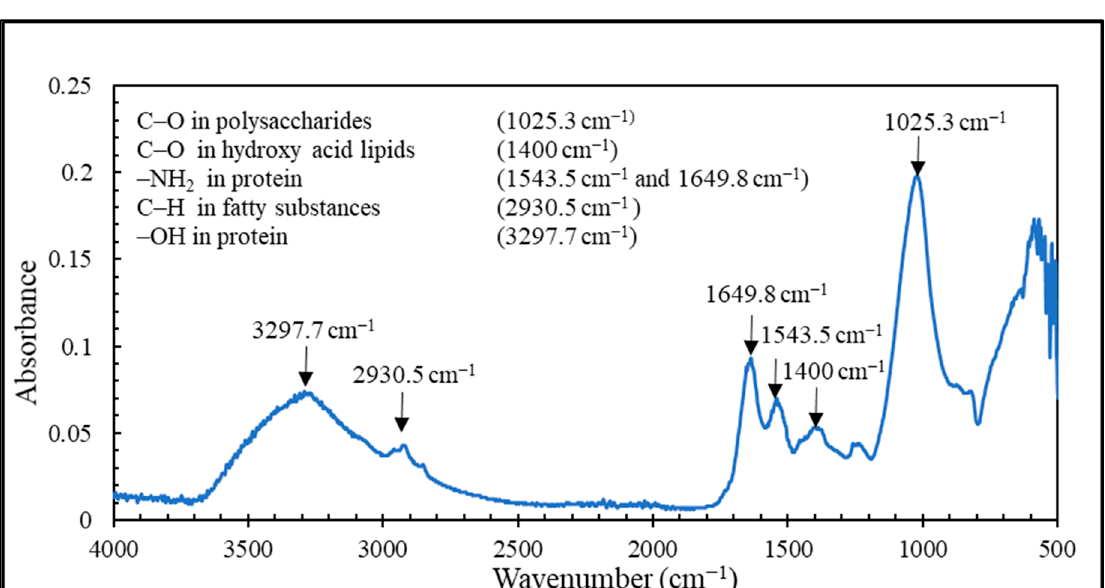
Figure 11. FTIR spectroscopy of UF membrane foulants.